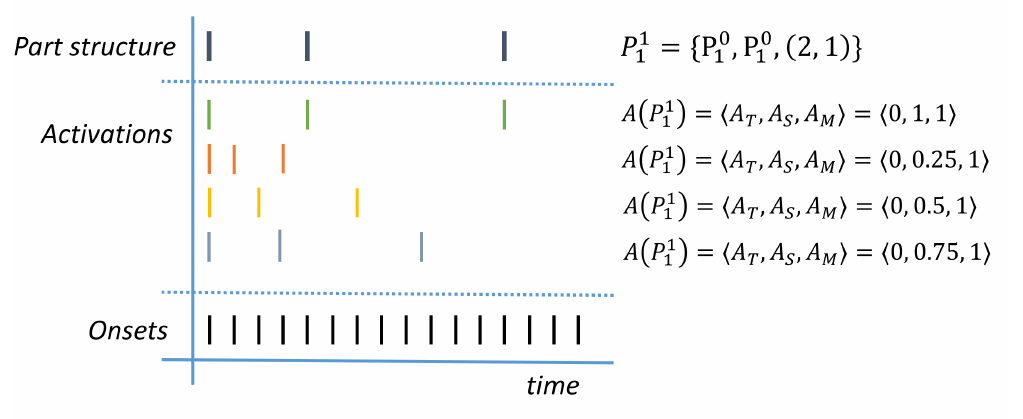
Figure 4. An L 1 part with three events is activated on a simple input signal. Four activations are shown, all occurring at the same time, but with different scales encoded in A S (between 0.25 and